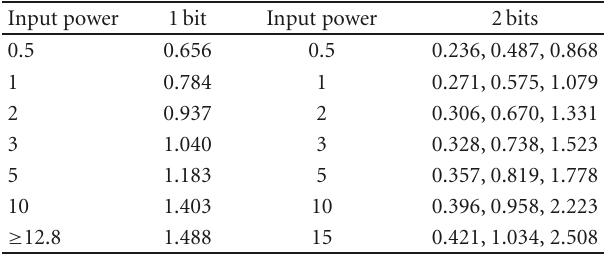
Table 3: Optimal quantization boundaries, reliable quantization region detection, long-term power constraint, and CG distribution: Log-normal, γ =